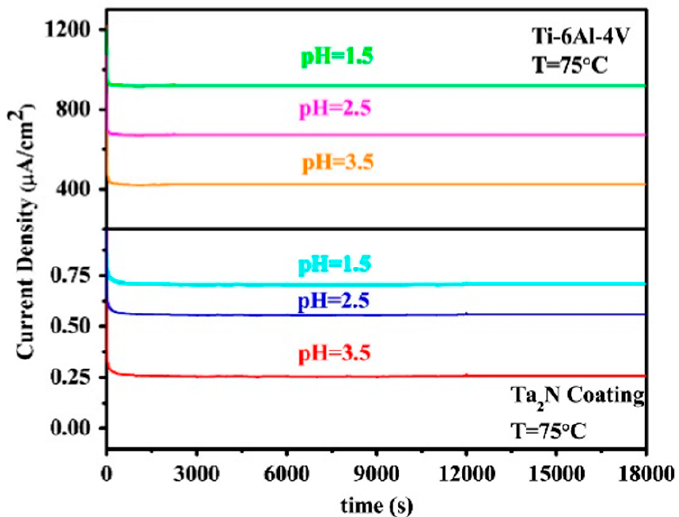
Figure 12. Influence of electrolyte pH (0.05M SO 42 − with 2 ppm HF) on current density of Ti-Al6-V4 and Ta 2 N coating at potentiostatic polarization. Reprinted from [31] copyright (2016), with permission from Elsevier.